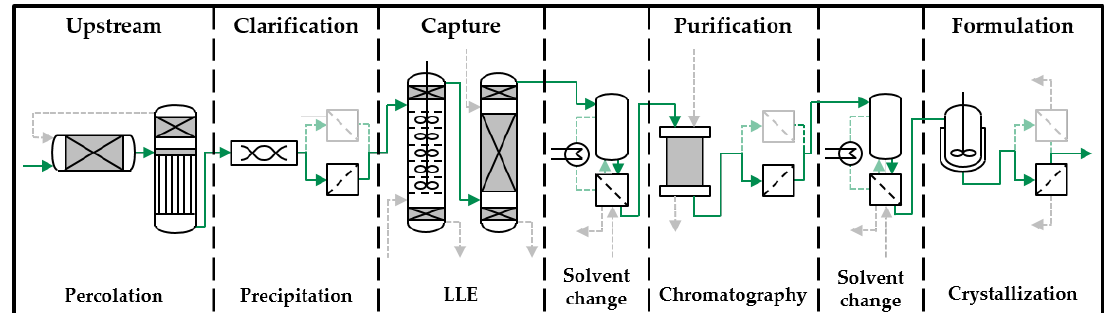
Figure 1. Basic process design for plant-based substances (LLE, liquid-liquid extraction) [8].